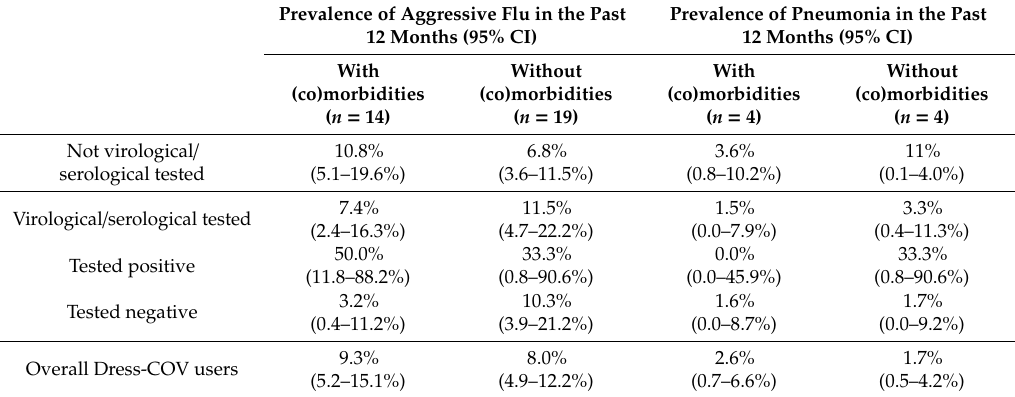
Table 2. Dress-COV: Prevalence (95% CI) of previous events of pneumonia and flu in the past 12 months.